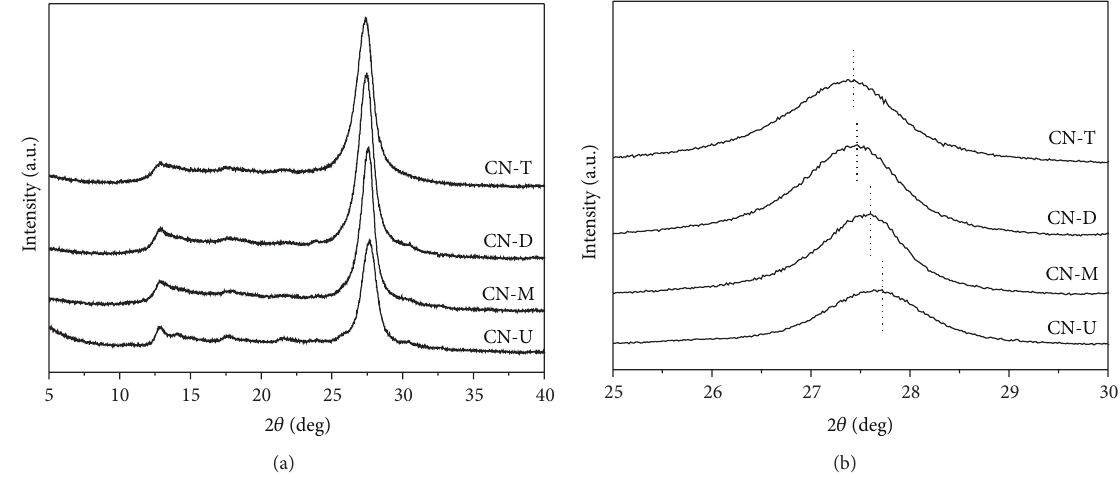
Figure 1: XRD patterns of the CN-T, CN-D, CN-M, and CN-U (a) and enlarged view of the (002) peak (b).